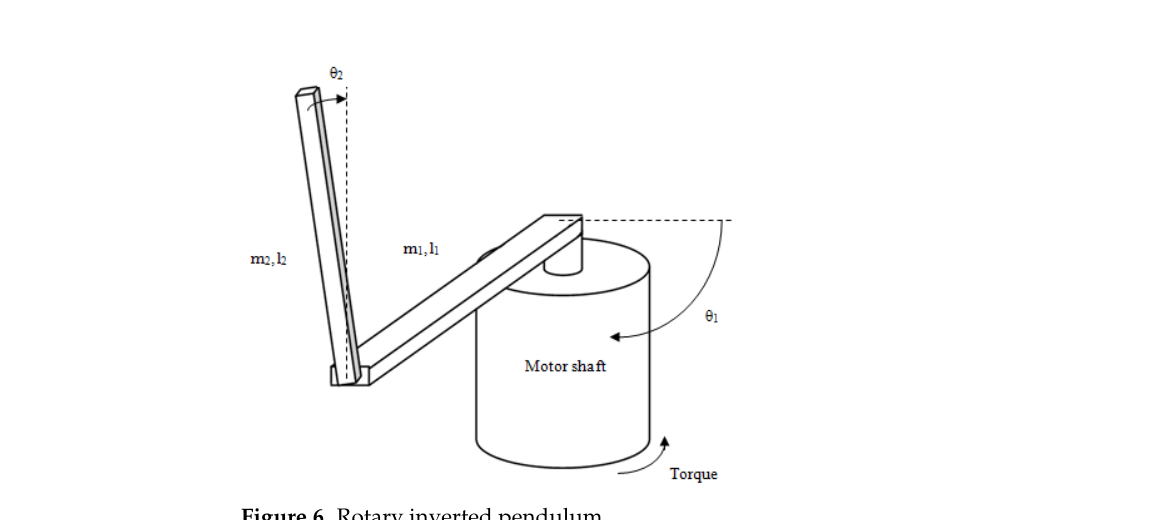
Figure 6. Rotary inverted pendulum. Table 9. List of parameters of rotary inverted